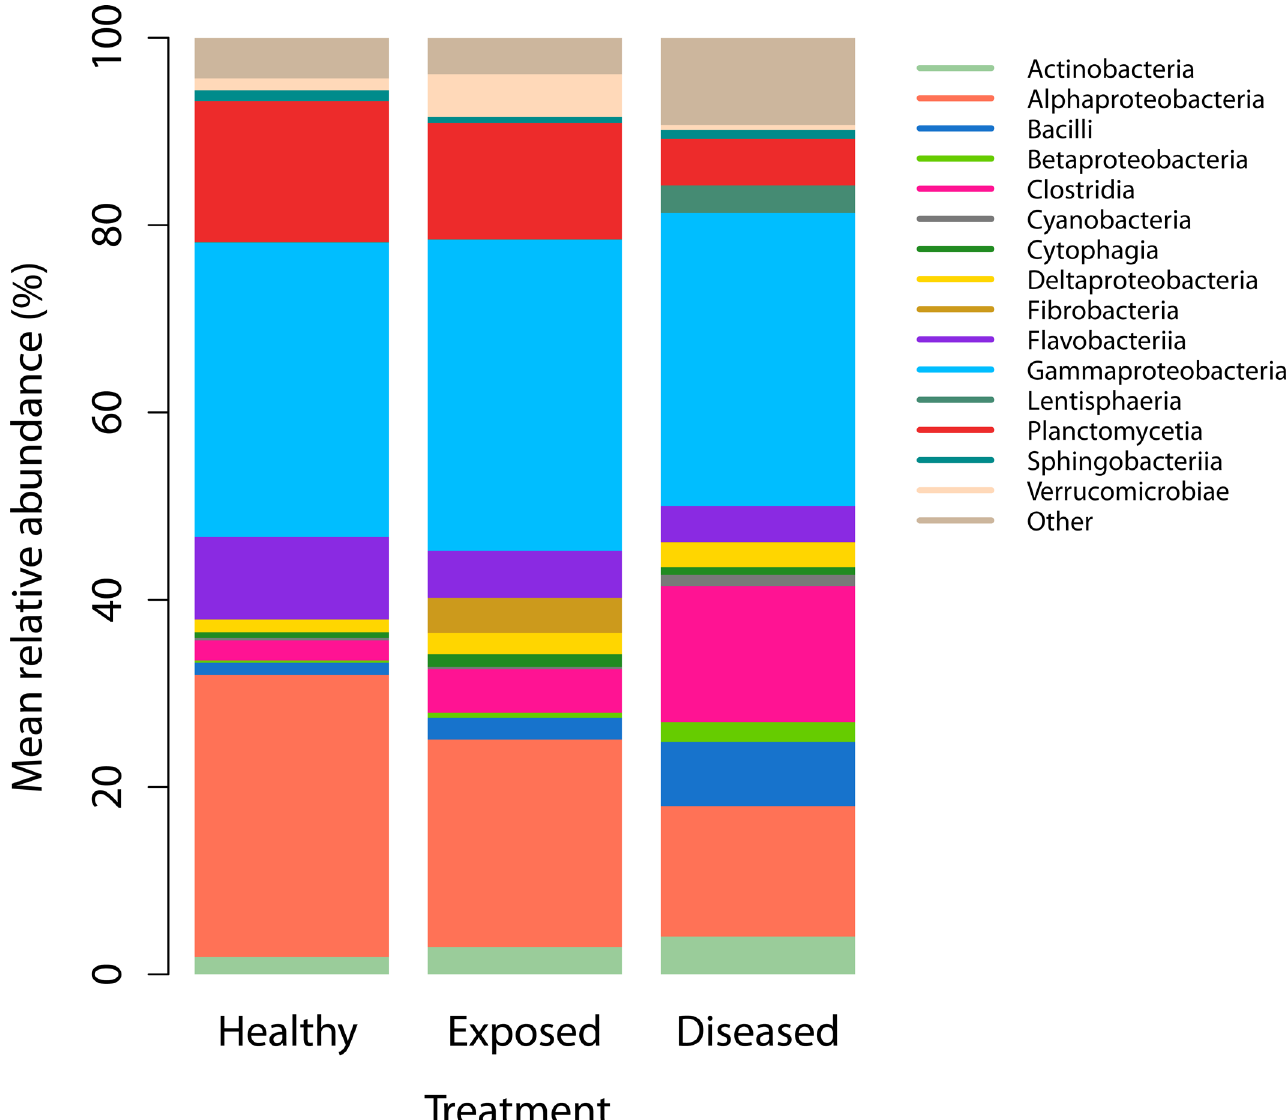
Fig 7. Relative abundance of bacteria in coral tissue. Mean bacterial community structure on healthy, exposed, and dark-spot tissue of Siderastrea siderea , including the 10 most abundant taxonomic classes from each experimental condition (totaling 12 classes). None of the most abundant classes were found exclusively in any one